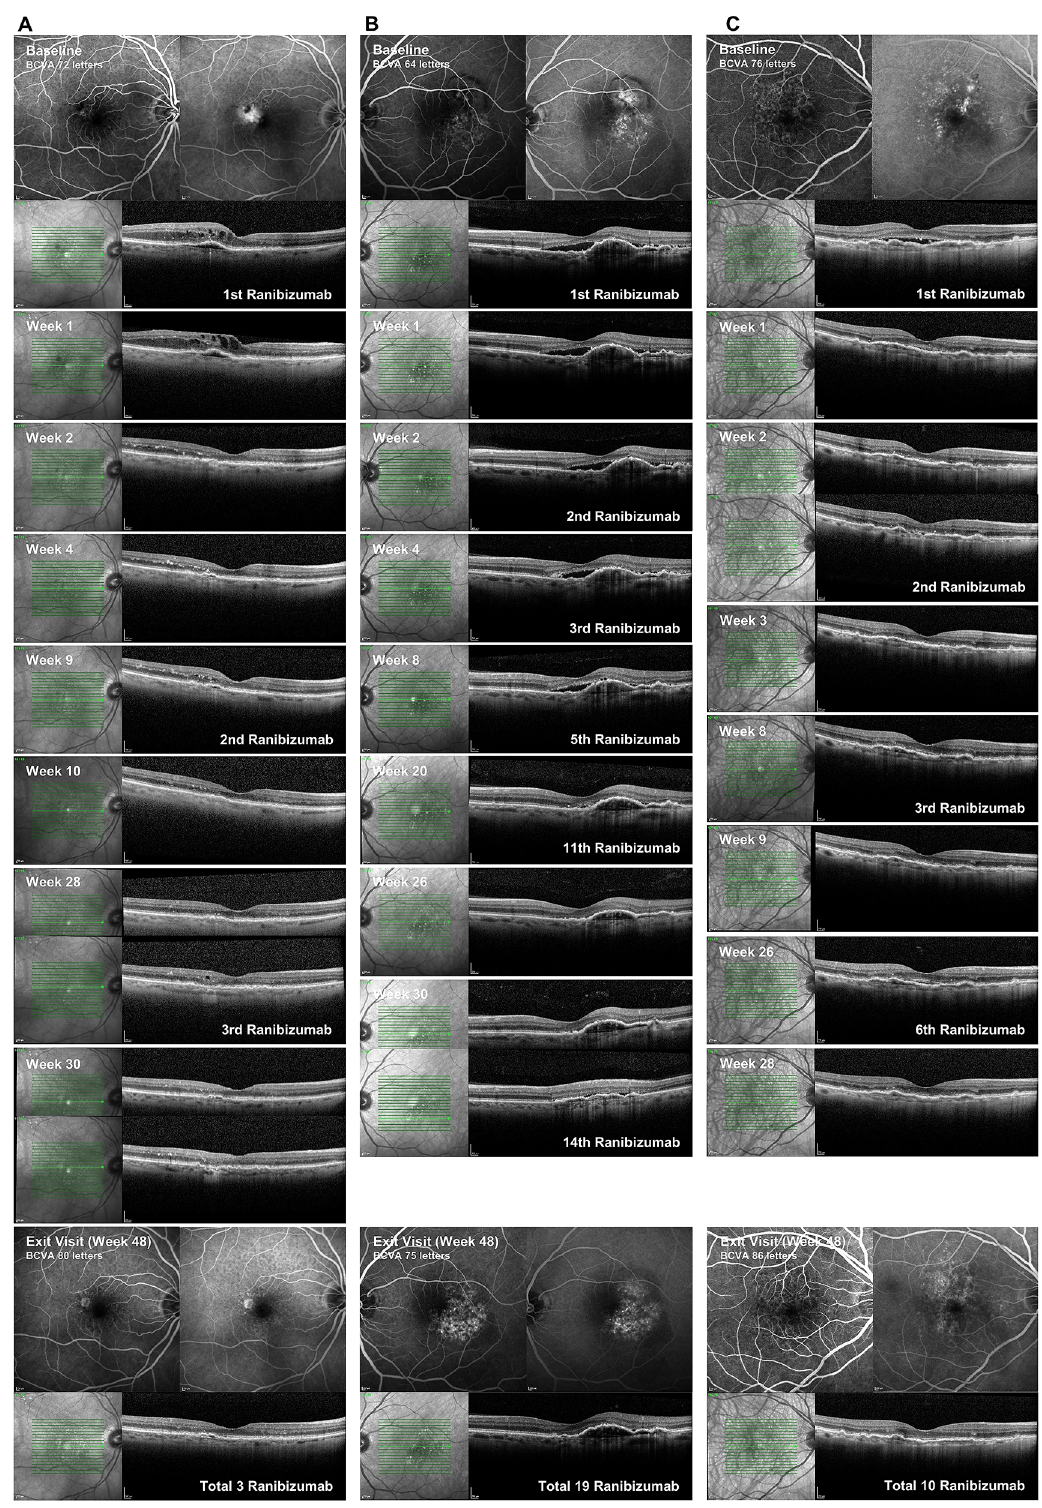
Figure 2. Examples of different activation/reactivation patterns (first line—baseline findings on fluoresceine angiography (FA) early and late phase and SD-OCT; last line—exit visit (48 weeks) FA early and late phase and SD-OCT; in between selected SD-OCT follow-up scans): ( A ) Type 3 CNV with only two reactivations during 12 months follow-up, no persisting fluid/early reactivation 2 or 3 weeks after last treatment and therefore never fulfilling the criteria for early retreatment, total 3 injections, BCVA gain 8